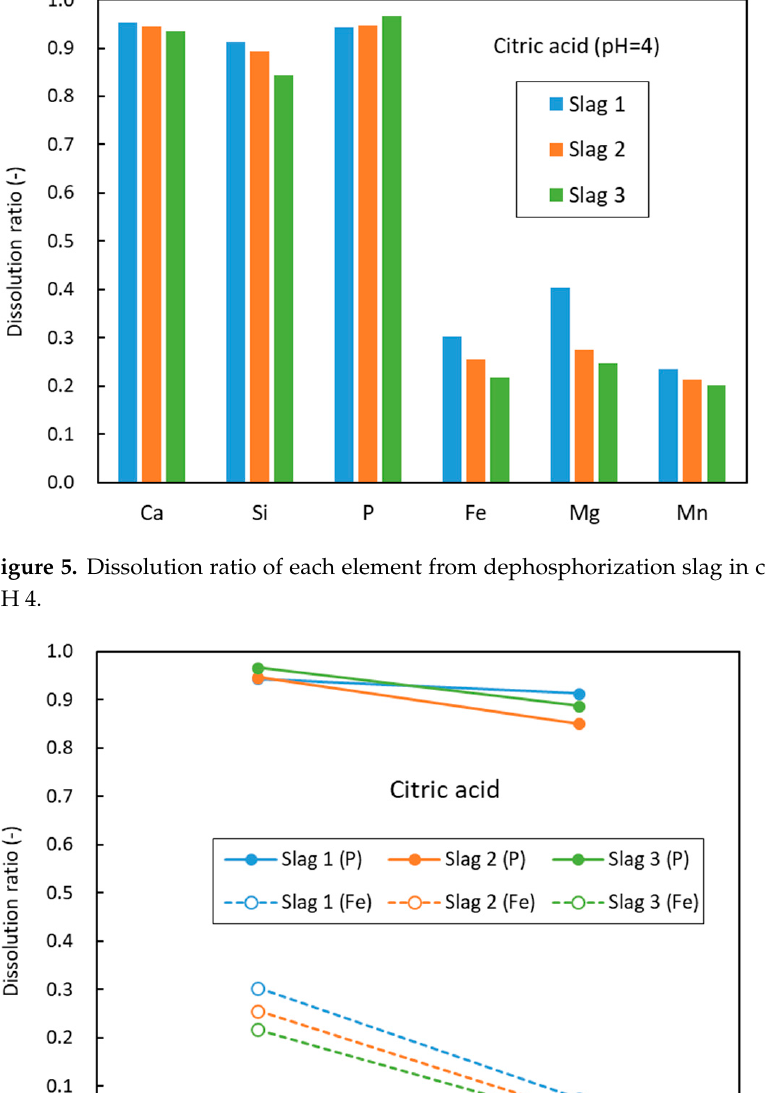
7 of 13 Figure 4. Dissolution ratio of each element from dephosphorization slag in hydrochloric acid solu ‐ tion at various pH conditions. Citric acid was commonly used as a leaching agent in previous studies [21–23]. To understand the effect of acid and select an appropriate leaching agent, the dissolution be ‐ havior of dephosphorization slag with different amounts of Fe 2 O 3 content in citric acid solution was also investigated. Figure 5 shows the dissolution ratio of each element from slag at pH 4. Compared to the leaching results in Figure 3, dephosphorization slag was easier to dissolve in the citric acid solution. Almost all the Ca, Si, and P was dissolved, and the dissolution ratios of Fe, Mn, and Mg were relatively high. In the citric acid solution, citrate ions (C 6 H 5 O 73 − ) could combine with Ca 2+ and Fe 3+ ions to form complexes [25]. It has been reported that the formation of complexes on the surface of the mineral phase shifts the electron density toward the metal ion, which destabilizes the crystal lattice and facilitates the detachment of metal ions into aqueous solutions [26]. Therefore, citric acid